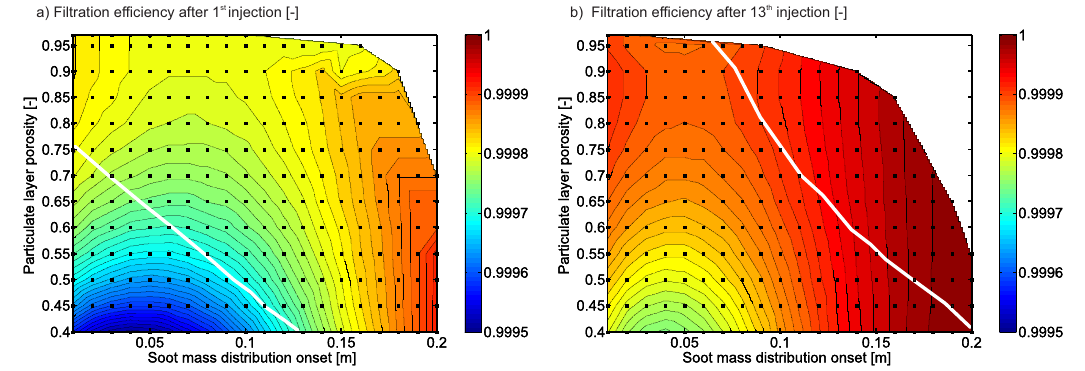
Figure 13. Filtration efficiency as a function of the particulate layer porosity and the soot mass distribution onset after different injection